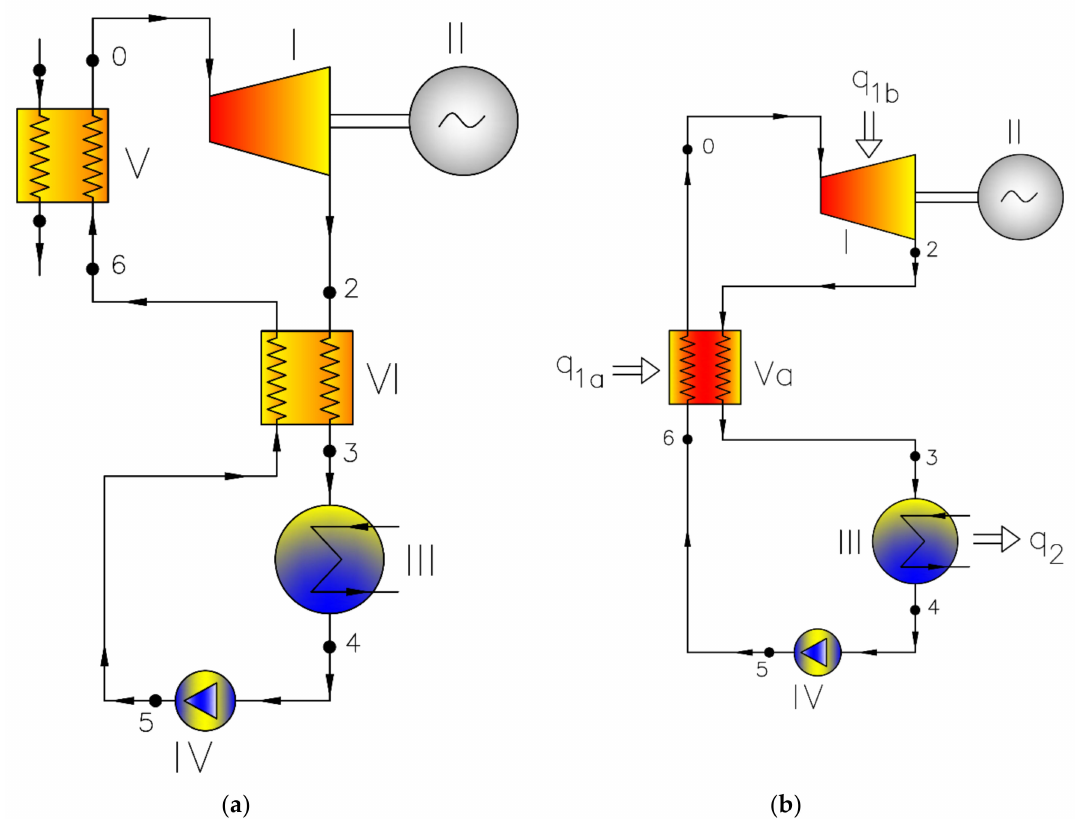
Figure 1. Standard Organic Rankine Cycle (ORC) cycle for wet fluids ( a ) and cycle with modified vapor generator and isothermal expansion ( b ); where: I—turbine, II—generator, III—condenser, IV—main pump, V—vapor generator, Va—regenerator and vapor generator, VI—regenerator, q 1 a —heat delivered in vapor generator, q 1 b —heat delivered during isothermal expansion, q 2 —heat rejected with the water cooling